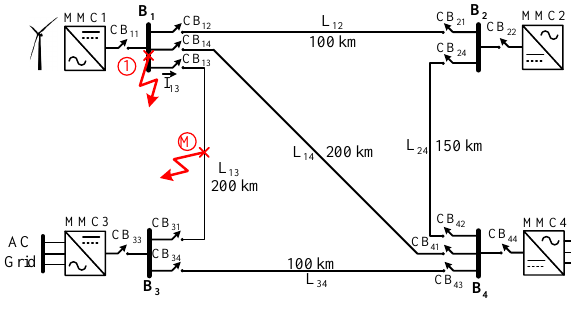
Fig. 4. Test multi-terminal HVDC grid